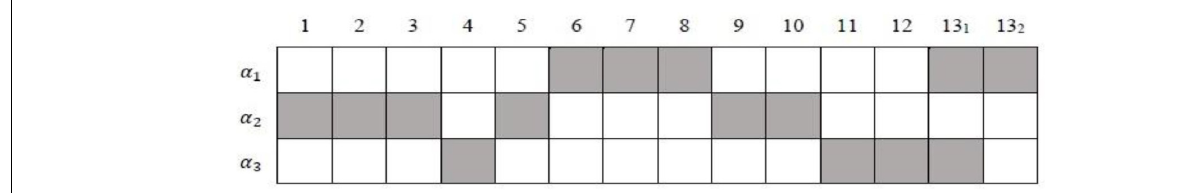
FIGURE 4 | The Q c -matrix for Booklet 1 data from TIMSS 2007. 13 1 and 13 2 denote the 1 st and 2 nd tasks of item 13, respectively.